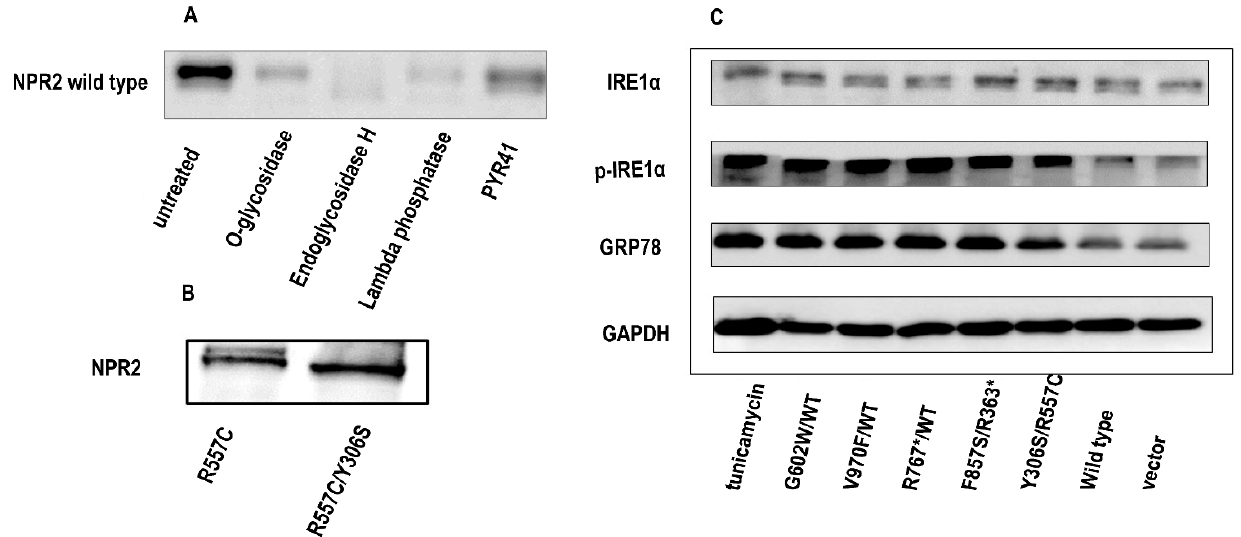
Figure 6. Natriuretic peptide receptor 2 ( NPR2 ) mutants induce the endoplasmic reticulum stress-unfolded protein response (ERS-UPR) in ATDC5 chondrocytes. ( A ) ATDC5 cells were transfected with NPR2 WT for 36 h. ATDC5 cell lysates treated with control (no treatment), O-glycosidase, endoglycosidase Endo-H, PYR-41, and Lambda Phosphatase, respectively, and resolved by sodium dodecyl sulfate–polyacrylamide gel electrophoresis are shown. ( B ) N-glycosylation of the R557C NPR2 mutant. When expressed alone, the R557C mutant is N-glycosylated. However, when co-expressed with the Y306S mutant, the N-glycosylated form of R557C mutant disappears. ( C ) Induction of the UPR by NPR2 mutants. The expression of glucose-regulated protein, 78 kD (GRP78), and p-inositol-requiring enzyme 1 α (IRE1 α ) is analyzed by Western blotting in ATDC5 cells transfected with wild-type or mutated NPR2 . ATDC5 cells incubated with Tunicamycin for 12 h are used as a positive control for ERS and the UPR. WT—wild type; GAPDH—glyceraldehyde 3-phosphate dehydrogenase; PYR-41—a cell-permeable irreversible inhibitor of ubiquitin-activating enzyme E1. N-glycosylation is important for protein folding and sorting in the ER, and NPR2 mutant defective in N-glycosylation may not be properly folded and induce the UPR and ERS. The cellular “quality control system” recognizes misfolded proteins, which leads to two outcomes: (1) ER-related degradation or (2) ERS-UPR induced apoptosis. Based on NPR2 gene mutants were likely to promote ERS-UPR-related apoptosis. To verify this hy- pothesis, NPR2 WT / NPR2 G602W , NPR2 WT / NPR2 V970F , NPR2 WT / NPR2 R767* , NPR2 R363* / NPR2 F857S ,